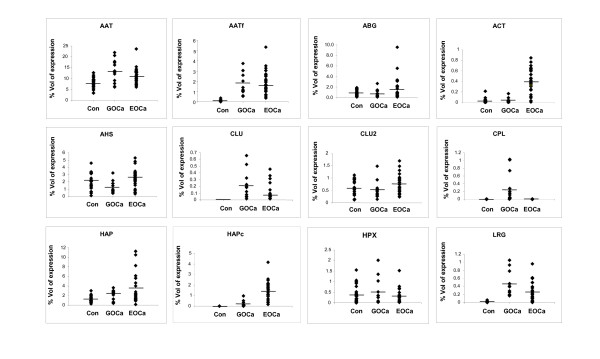
Percentage of volume contribution of 2-DE detectable serum proteins of control women (Con) and patients with EOCa and GOCa. Percentage of volume contribution (%vol) of protein spots was analyzed by ImageMaster™ 2D Platinum Software Version 5. Analysis was restricted to twelve clusters of protein spots.